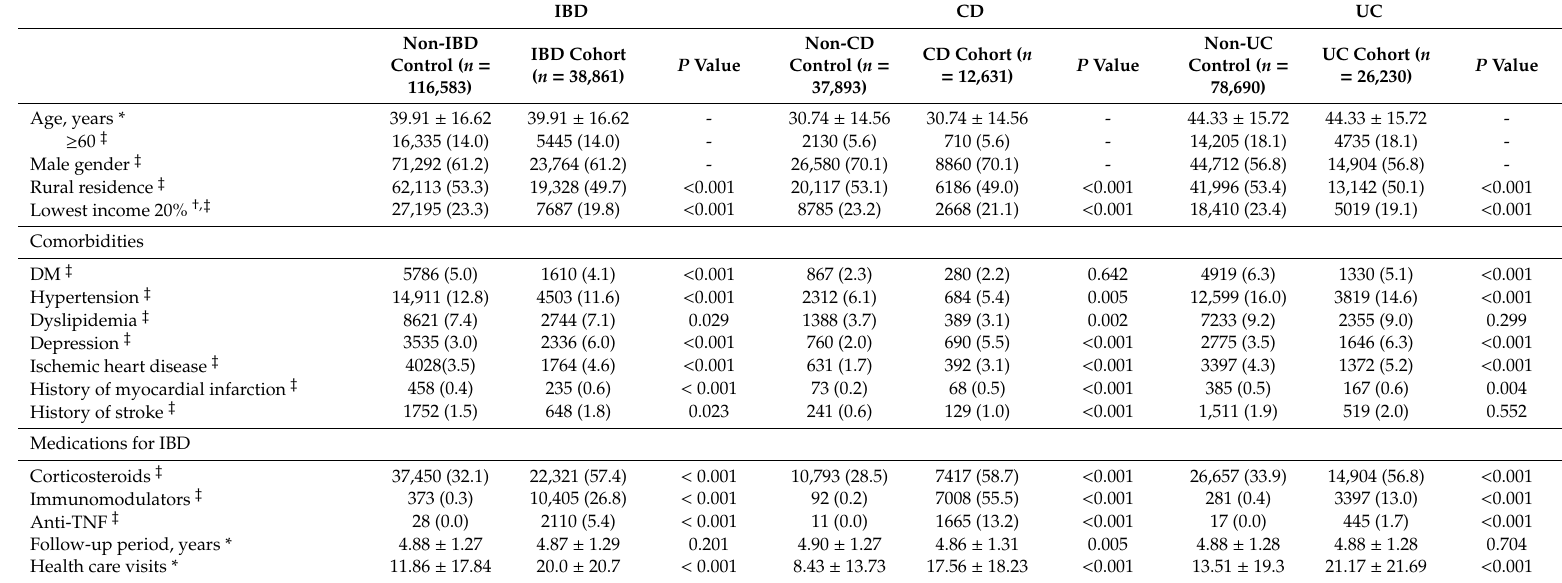
Table 1. Baseline characteristics of the study